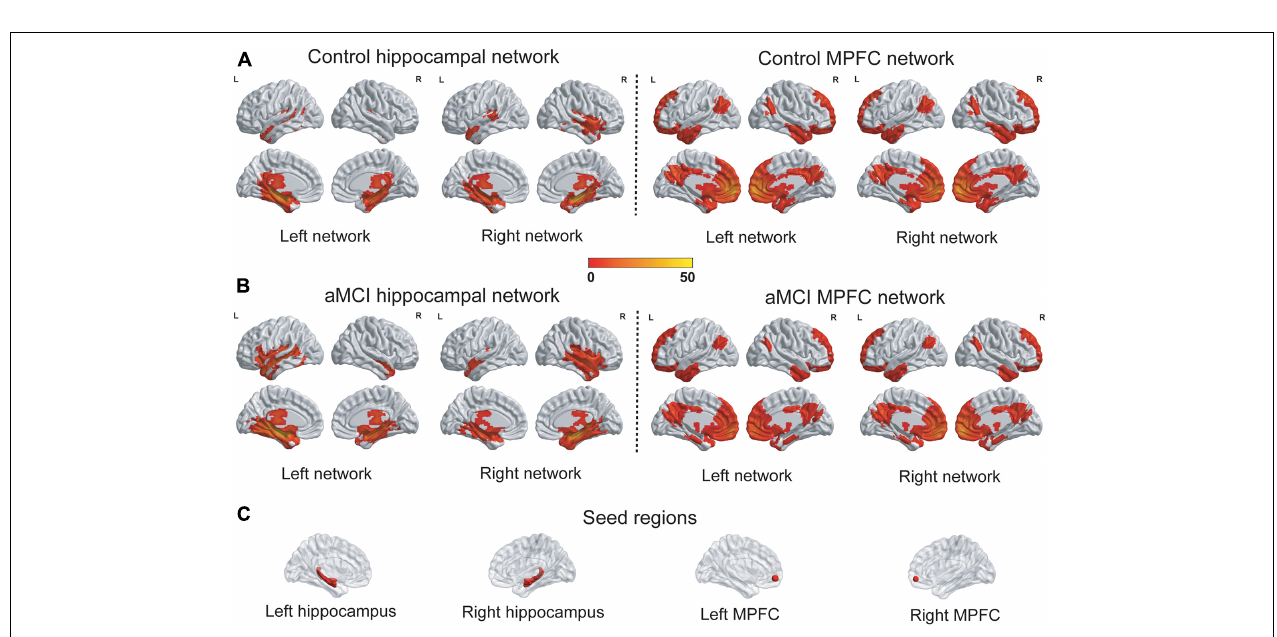
FIGURE 1 | Correlative analyses between episodic memory scales and executive function scales. (A,B) The scores of the episodic memory scales were significantly positively correlated with the executive function scales in the aMCI group, rather than in the control group. The statistical thresholds were set at a P < 0.05.